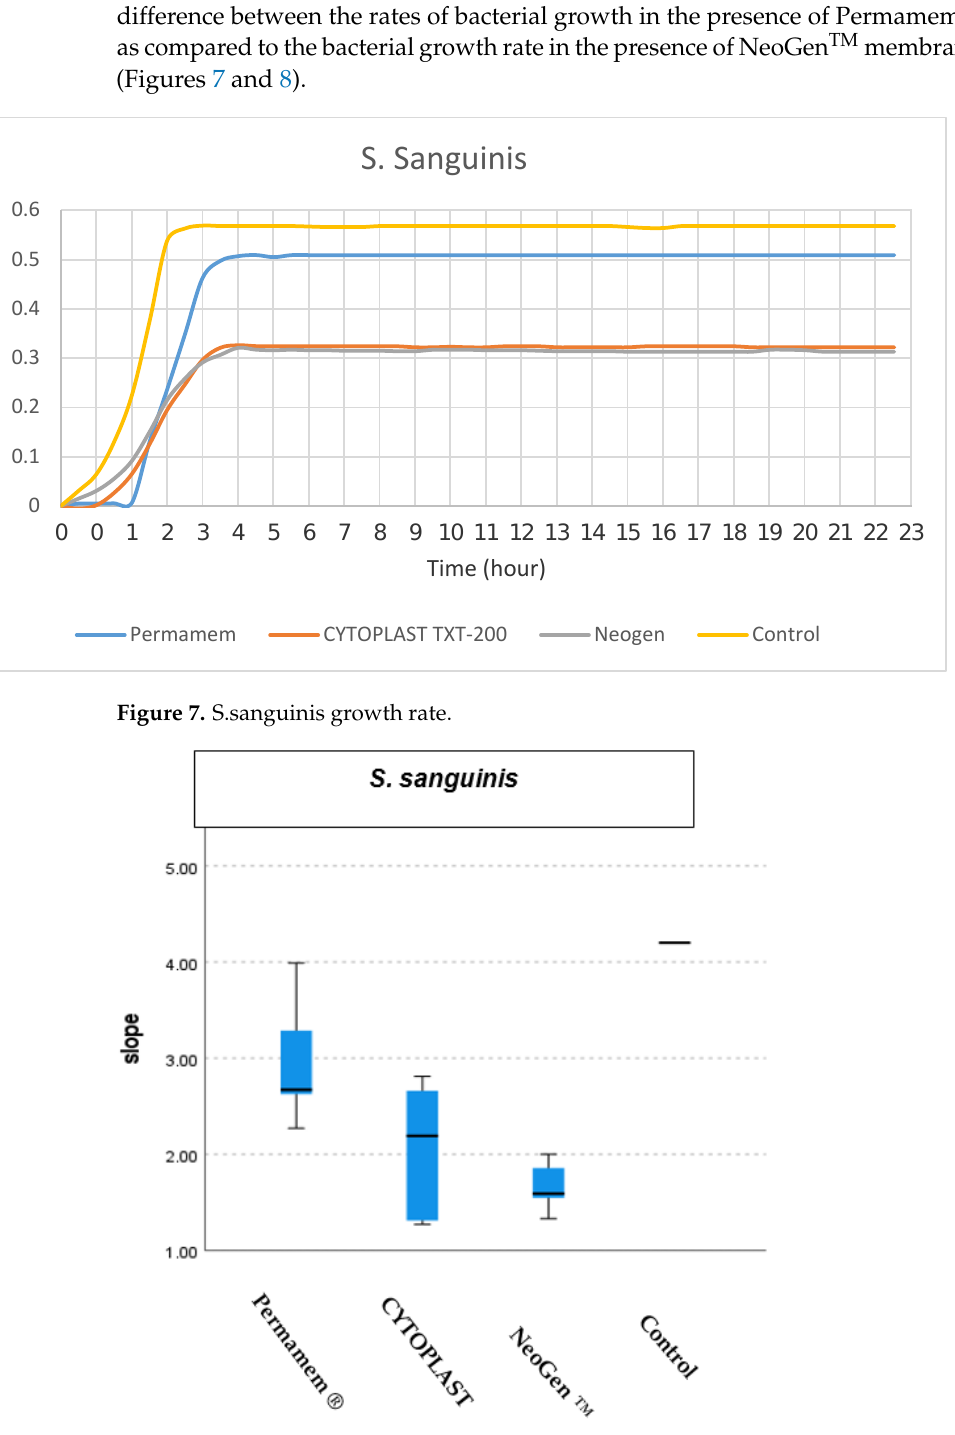
Figure 8. S. sanguinis growth distribution in the presence of the tested membranes and in a control group.